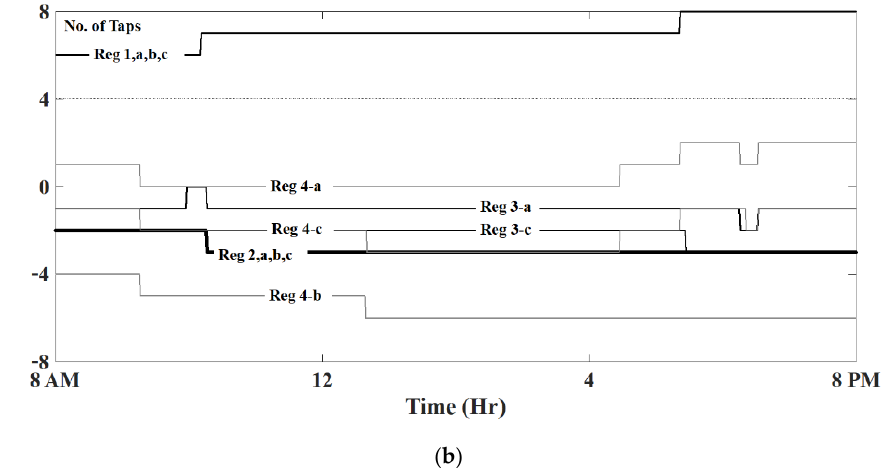
Figure 15. The reactive power compensation and voltage regulator action of Case 3: ( a ) The pu phase voltages, the available reactive from the WECS Q , and reactive power compensation Q c ( b ) Tap changes operation.